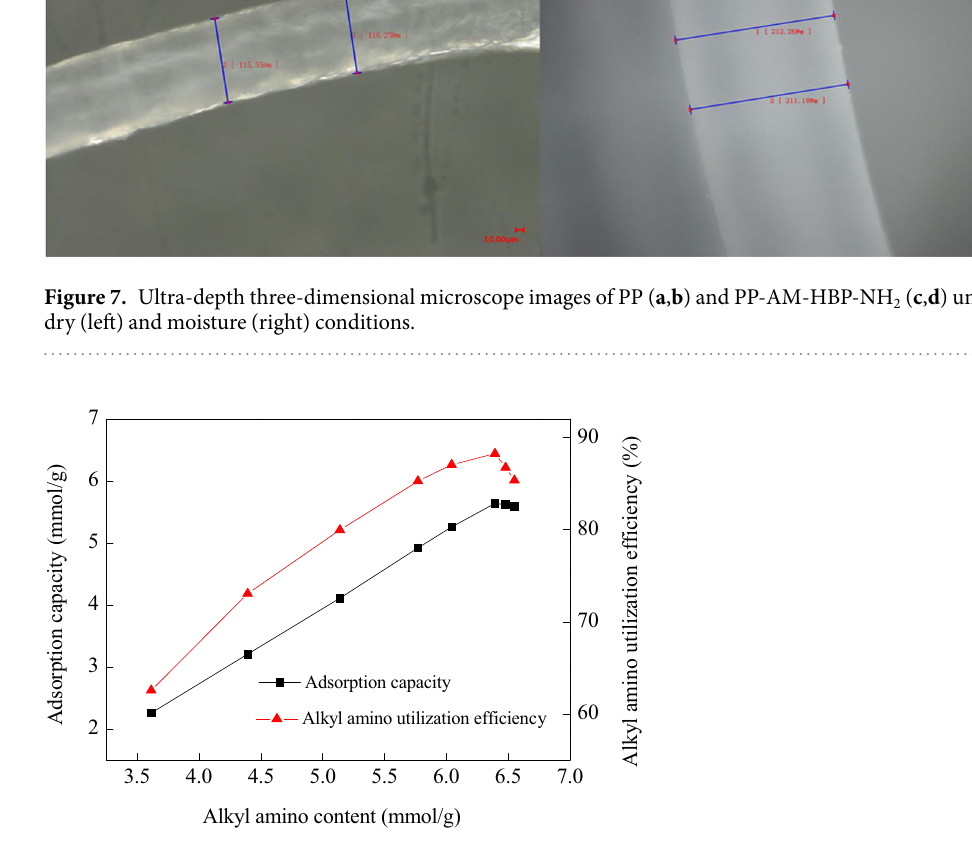
Figure 8. Effects of alkyl amino content on adsorption capacity of PP-AM-HBP-NH 2